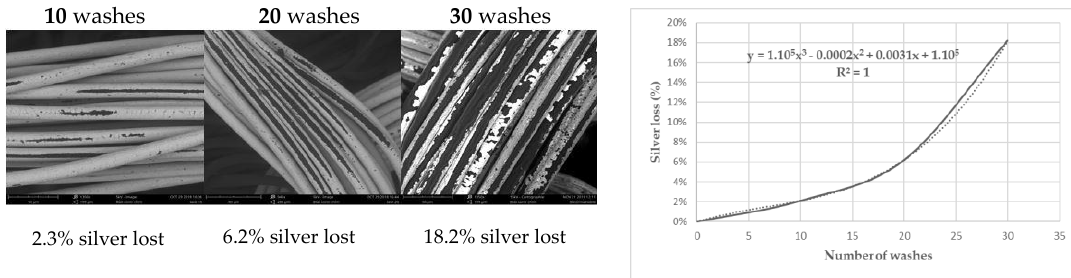
Figure 11. Evolution of the silver depletion with the washes, ( left ): SEM observations of the samples washed 10,20 and 30 times; ( right ): graph showing the silver loss according to the number of washes.